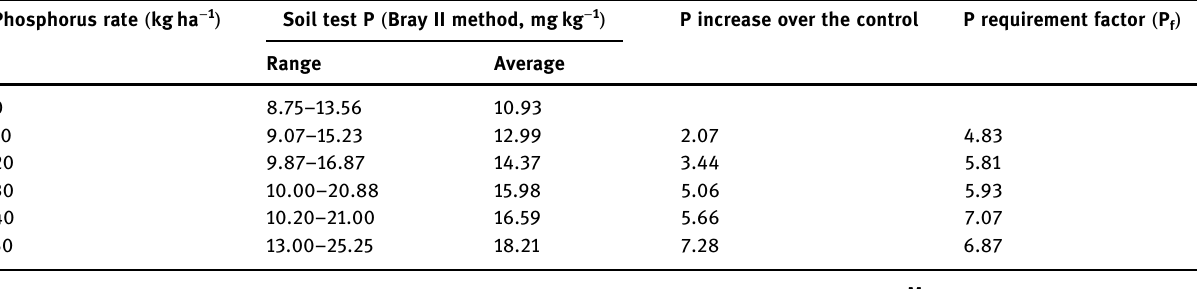
Table 4: Determination of phosphorus requirement factors ( P f ) for Bray II method calculated, based on soil test P from di ff erent fertilizer rate treatments on malting barley on Nitisols of Lemu – Bilbilo district of Arsi